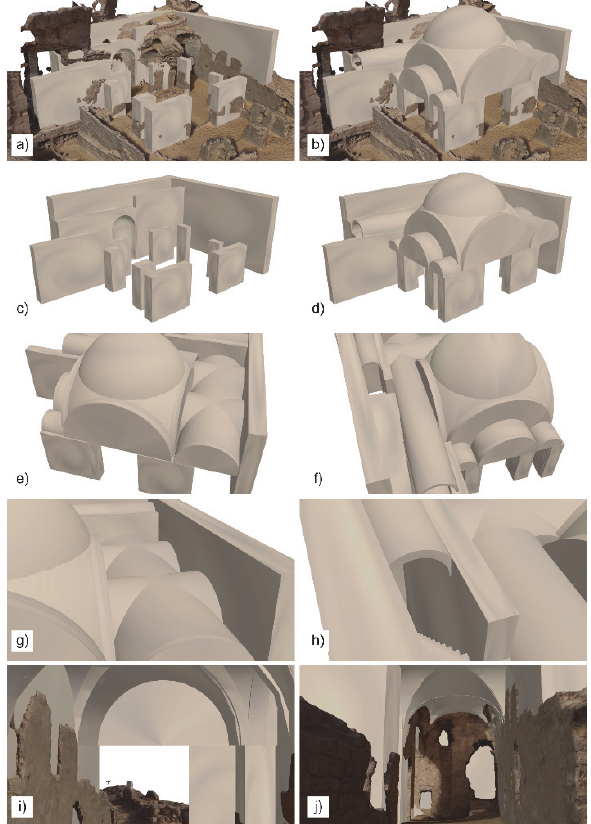
Figure 9. Preliminary virtual reconstruction of the Coptic Church: a) view of walls and 3D model; b) view of the church and 3D model; c) view of walls; d) view of the church; e) detailed view from east; f) detailed view from south; g) detailed view of the vaults; h) detailed view of stairs; i) and j) interior views of the